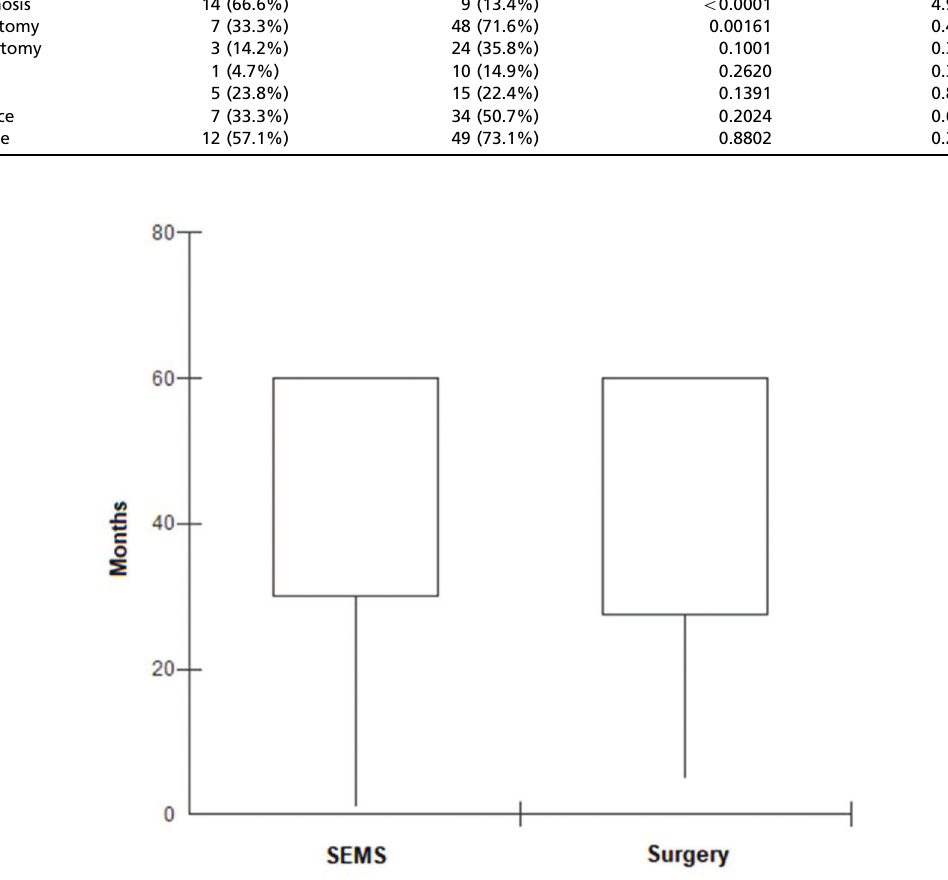
Figure 2 - Median follow-up time, interquartile boxplot comparing SEMS and emergency surgery ( p